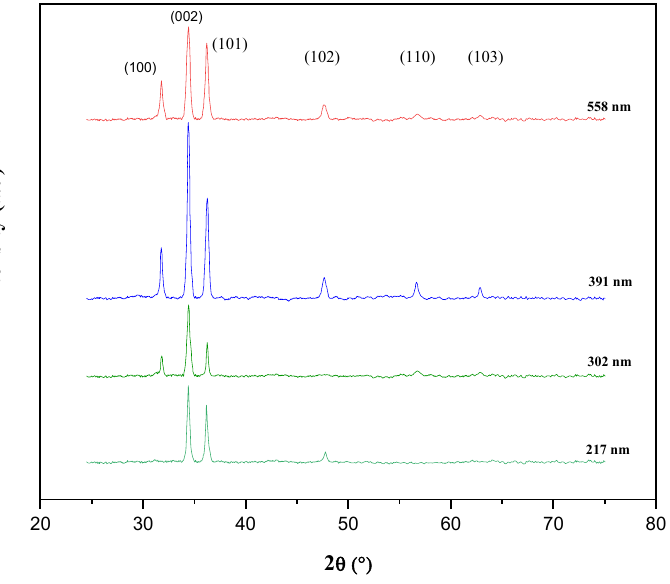
Figure 9. The XRD spectra of the deposited ZnO emitter thin films: thickness optimization. As can be seen from the recorded peaks, the deposited ZnO layer with 391 nm thickness shows an increase in intensity and crystallinity, compared to the sample with 302 nm and the other thicknesses, which can be related to an apparent crystallinity enhancement in the 391 nm ZnO layer. Moreover, the intensity of the (002) peak is stronger than the other peaks, signifying that ZnO crystallites are highly oriented with the c-axis. Table 2 lists the corresponding (002) peak structural parameters, such as the crystallite size (D), the dislocation density ( δ ), and the strain ( ɛ ) values [45], for both XRD patterns of the ZnO thin films with thicknesses of 302 nm and 391 nm, since they showed the best electrical and structural properties compared to the other samples.